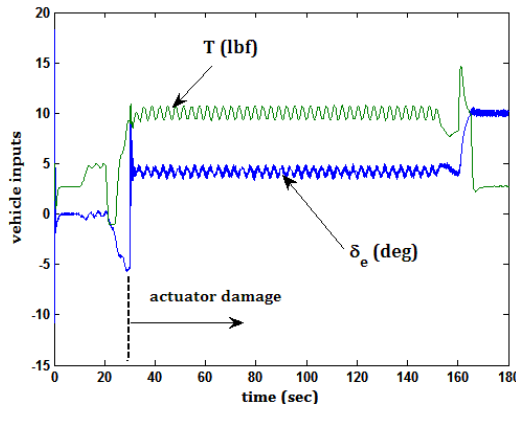
Figure 14. Elevator and thrust inputs for Task